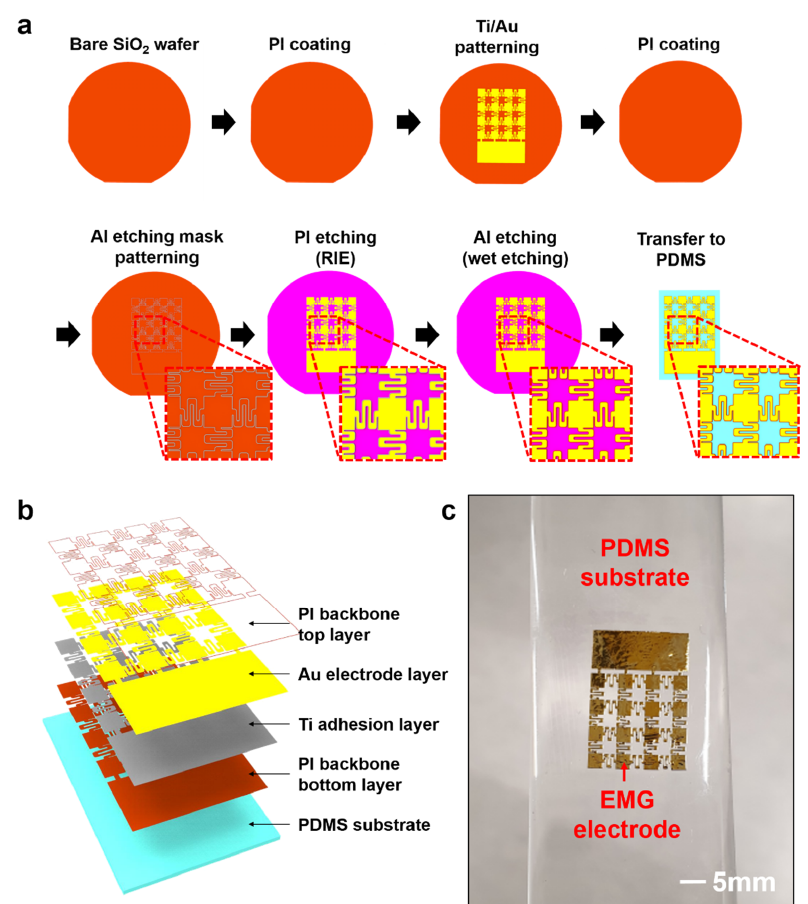
Figure 2. Schematic illustrations and photographic image of the ultrathin, stretchable electrode patch for EMG monitoring: ( a ) Fabrication process of the metal-based stretchable EMG electrode; ( b ) Each component layer of the device; ( c ) A photographic image of a stretchable EMG electrode